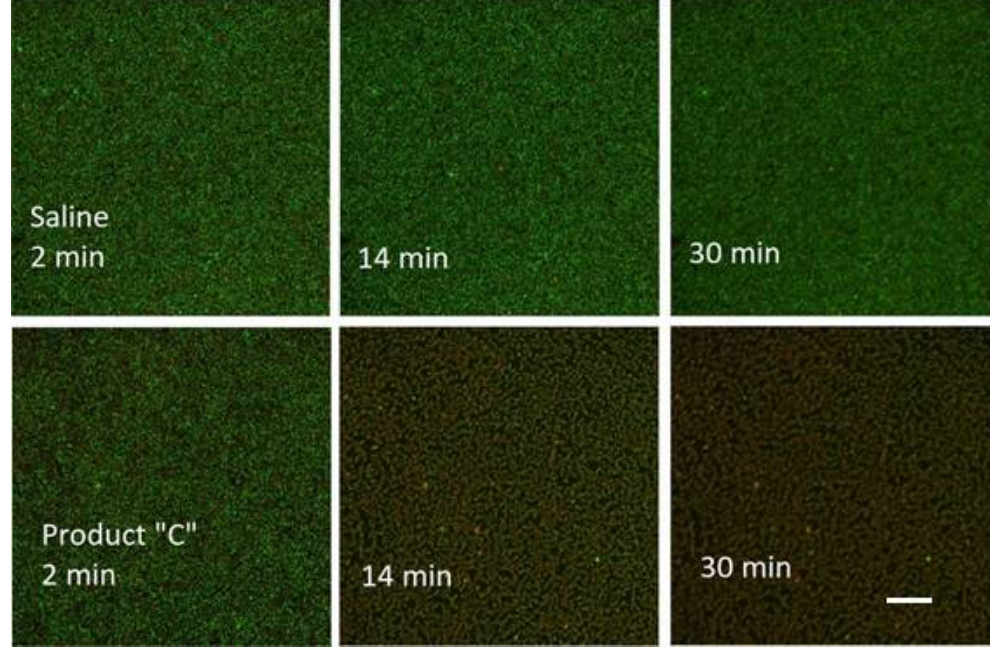
Figure 5. Points of a time series taken with a mixture of S. epidermidis and probiotic culture. Snapshots (composite images of green (G) and red (R) fluorescence; exposure G = 80 ms; R = 200 ms) with 20x/0.8NA lens of Zeiss AxioObserver microscope; scale bar in the Product “C” 30 min frame applies to all frames = 100 μm).